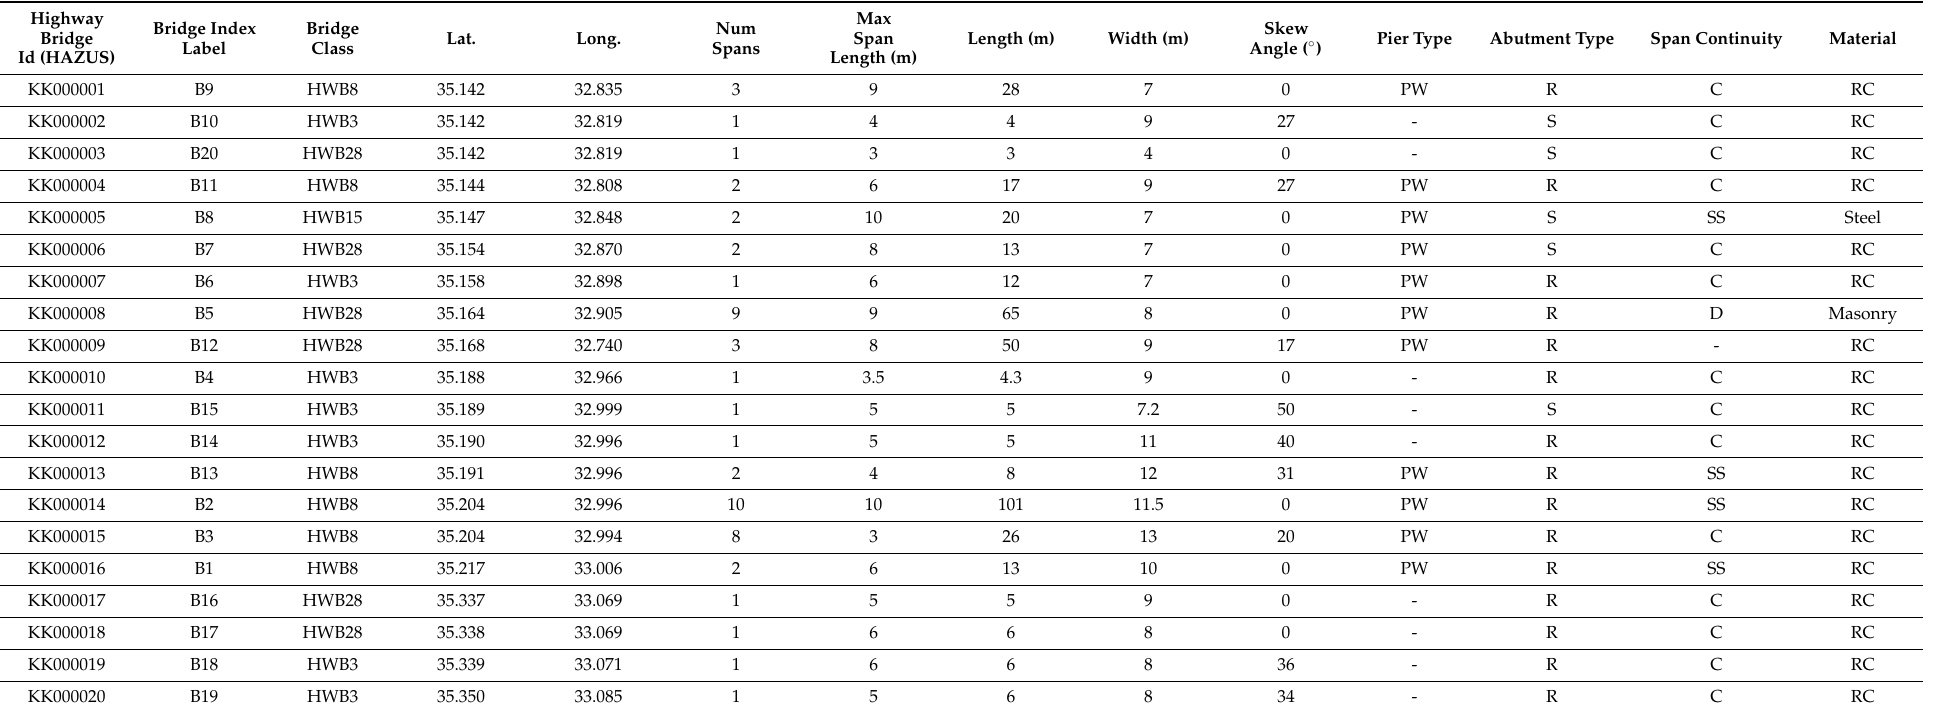
Table 5. Full bridge description and class